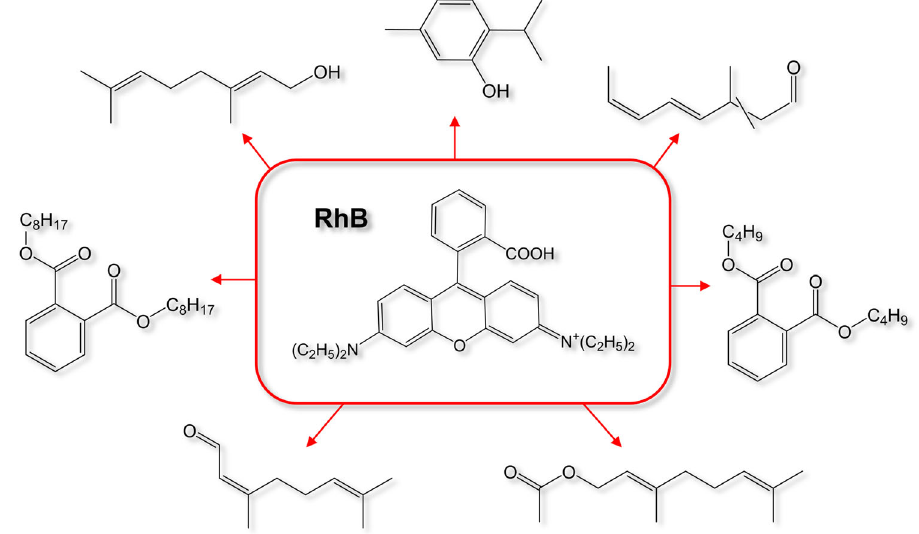
Fig. 9 Detected by-products. Produced by-products during the RhB